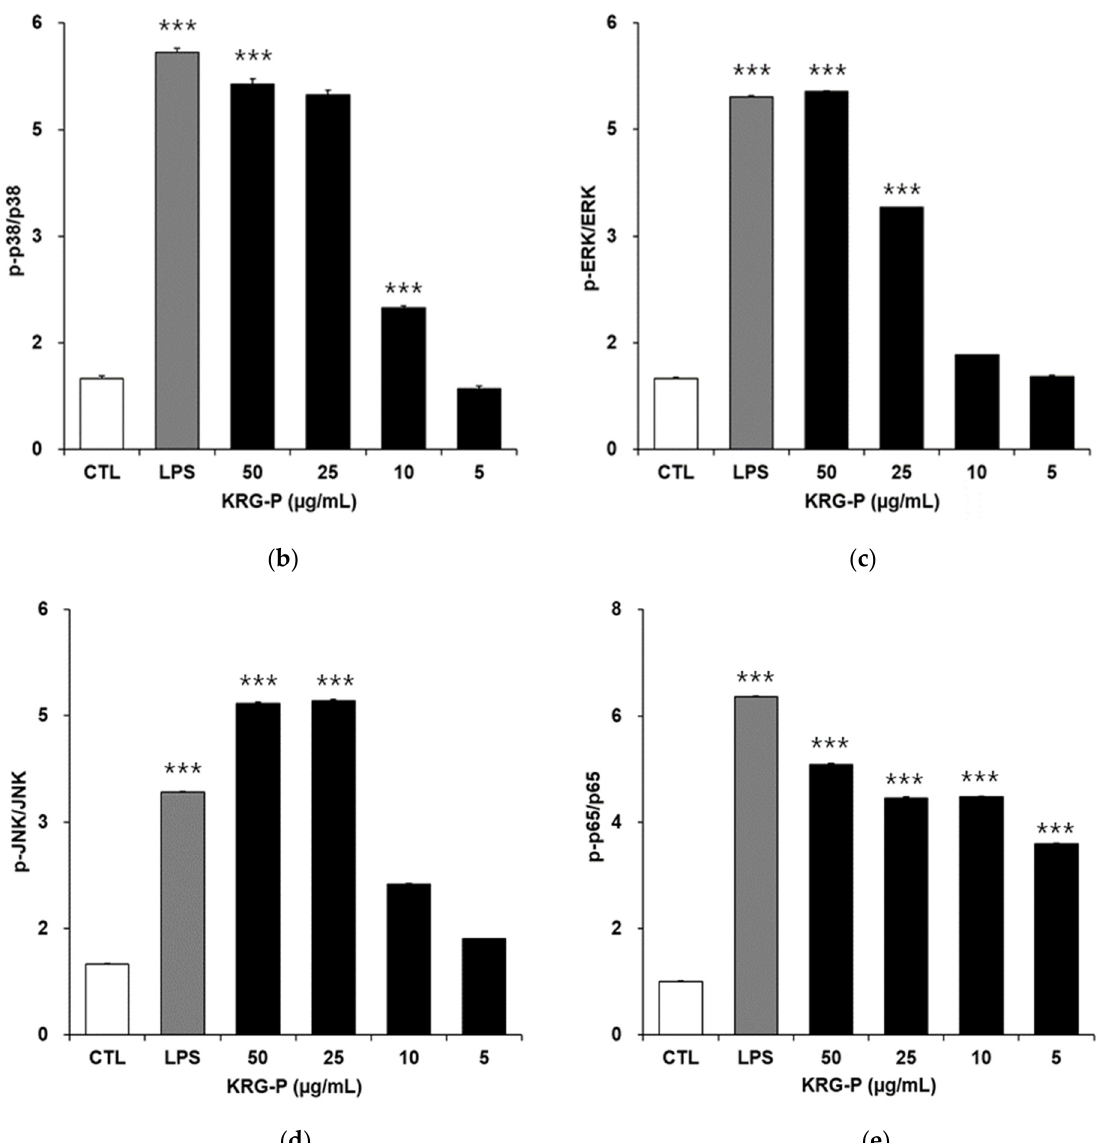
Figure 3. Activation of MAPK and NF- κ B pathways by treatment with KRG-P in RAW264.7 macrophage cells. ( a ) RAW264.7 cells (3.0 × 10 6 cells/well) were treated with KRG-P at a series of concentrations (5~50 µg/mL) or with LPS (500 ng/mL) in 6-well flat-bottom plate for 30 min. CTL; control, LPS; lipopolysaccharide. Western blots show the expression of the representative proteins. The bar graphs respectively show density ratios of p-p38 to total p38 ( b ), pERK to total ERK ( c ), pJNK to total JNK ( d ) and p-p65 to total p65 ( e ) as analyzed by ImageJ Software. Data are presented as the means ± SD. *** p < 0.001 vs. the control group.